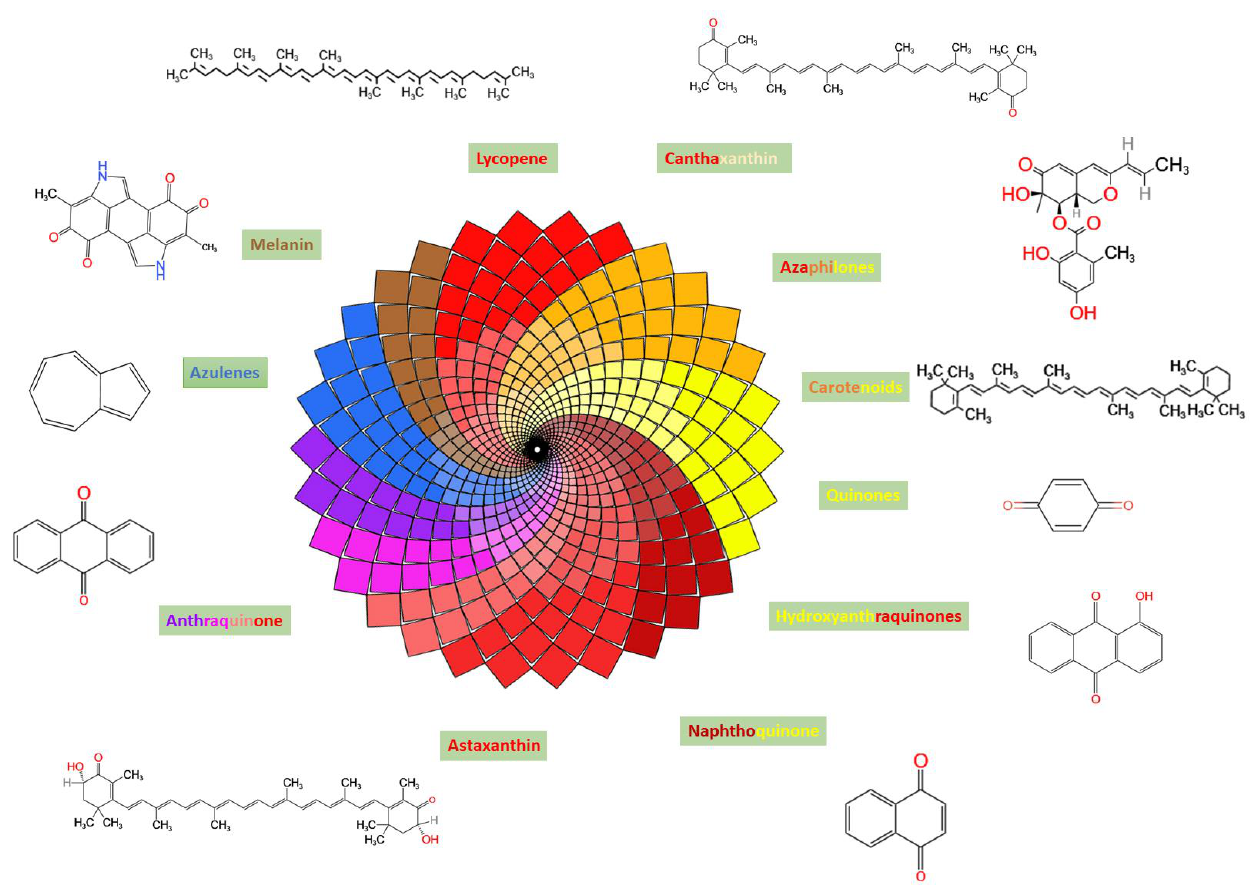
Figure 1. Fungal pigments (carotenoids and polyketides) exhibiting their color and their typical structure skeletons. Table 1. Fungal pigments and their potential applications.